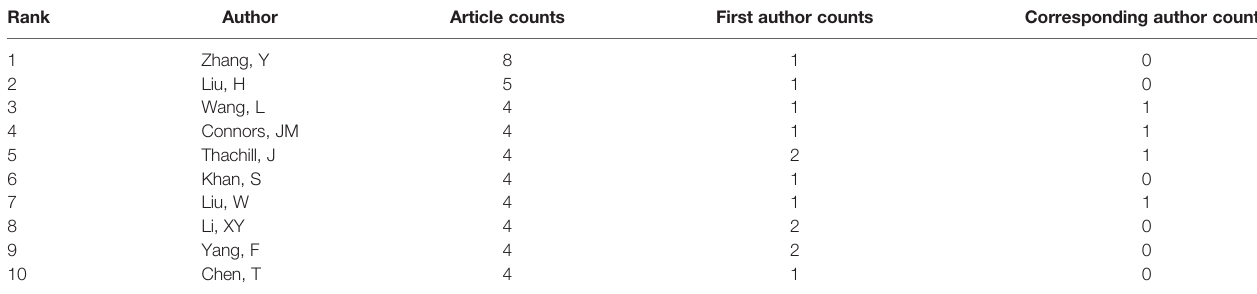
TABLE 1 | The top ten authors contributed to the research about COVID-19 complication and sequelae sorted by total number of